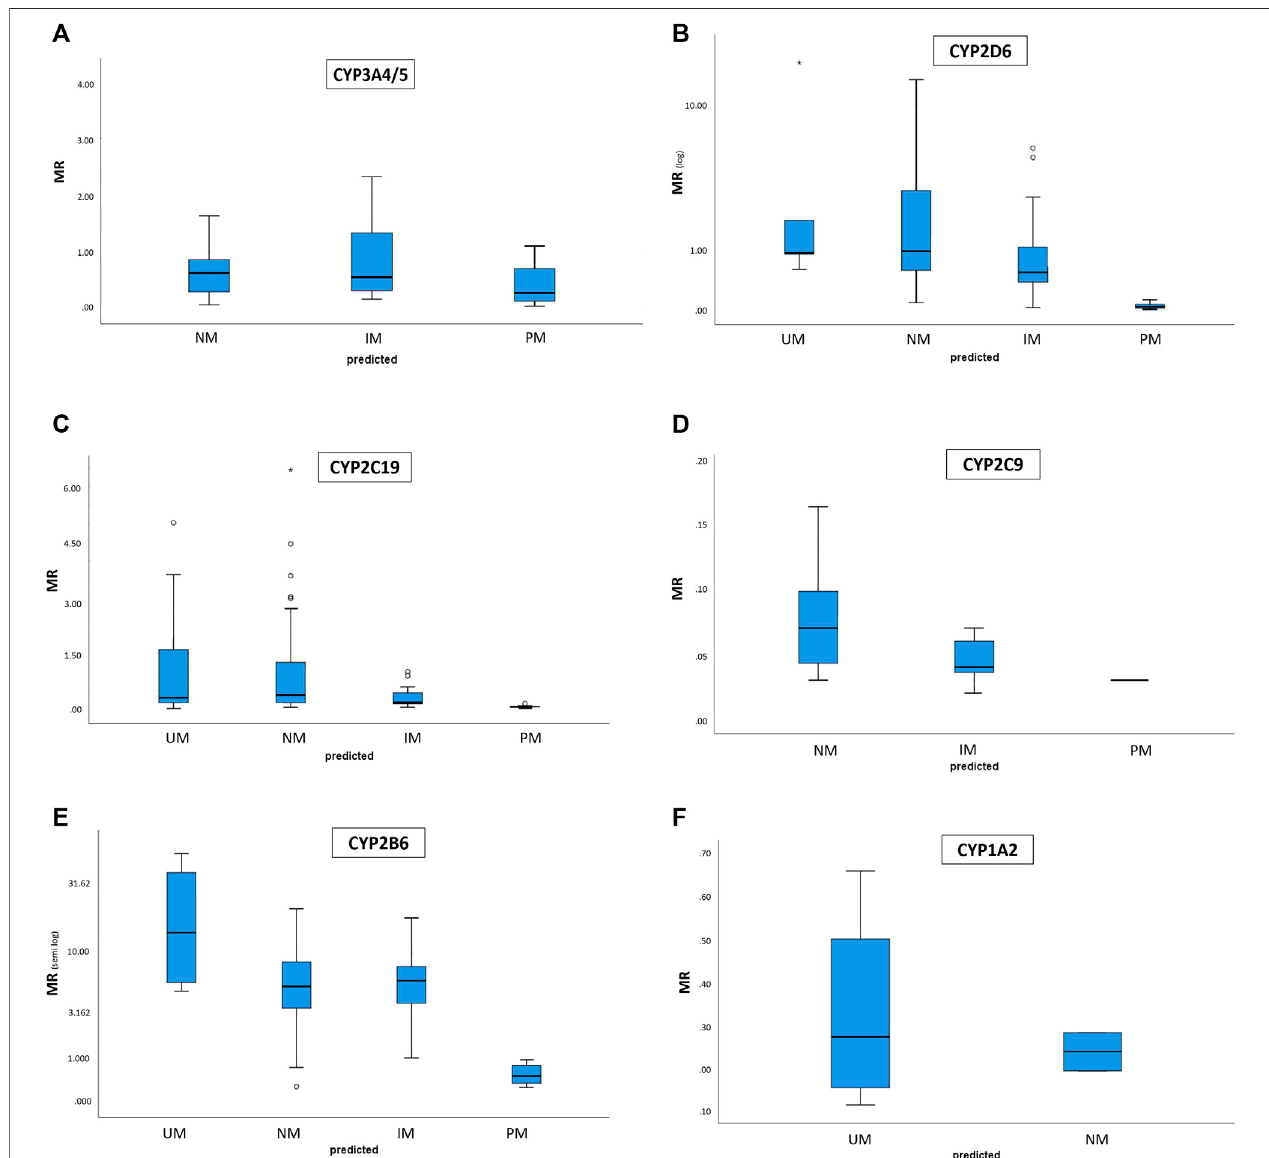
FIGURE 2 | Distribution of metabolic ratios (y axis) for each phenotype predicted by the genotype (x axis). Boxes indicate the interquartile ranges. (A) CYP1A2. (B) CYP2B6. (C) CYP2C9. (D) CYP2C19. (E) CYP2D6. (F) CYP3A4 and CYP3A5.